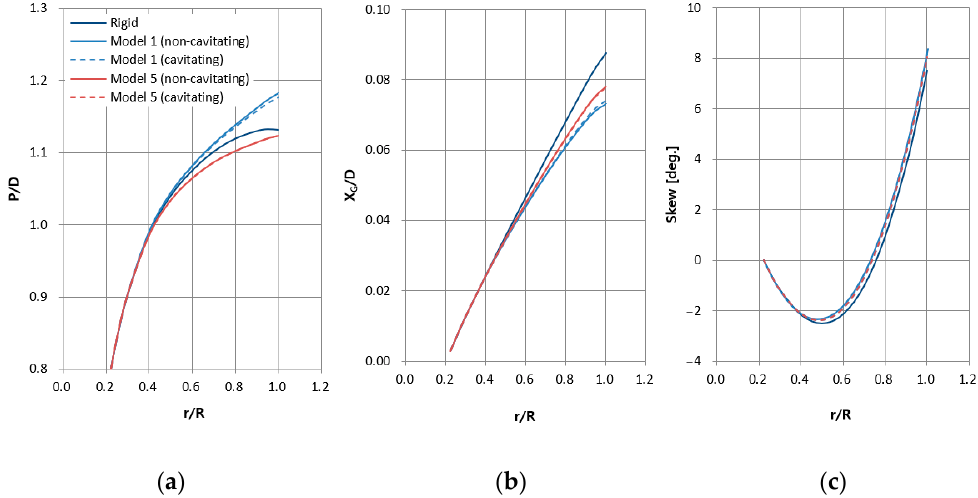
Figure 12. Shape parameters of rigid and composite propellers in non-cavitating and cavitating flows: ( a ) pitch distribution, ( b ) rake distribution, ( c ) skew distribution.